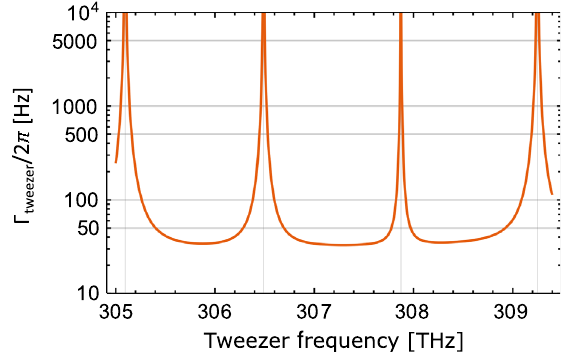
FIG. 7. Scattering rate due to the 15-mW 976-nm (307-THz) tweezer from a 3 Σ ð v 00 ¼ 24 Þ . The calculation is performed using the c 3 Σ potential from Ref. [39] and a 3 Σ potential from Ref. [47]. The peaks correspond to different vibrational states of the c 3 Σ